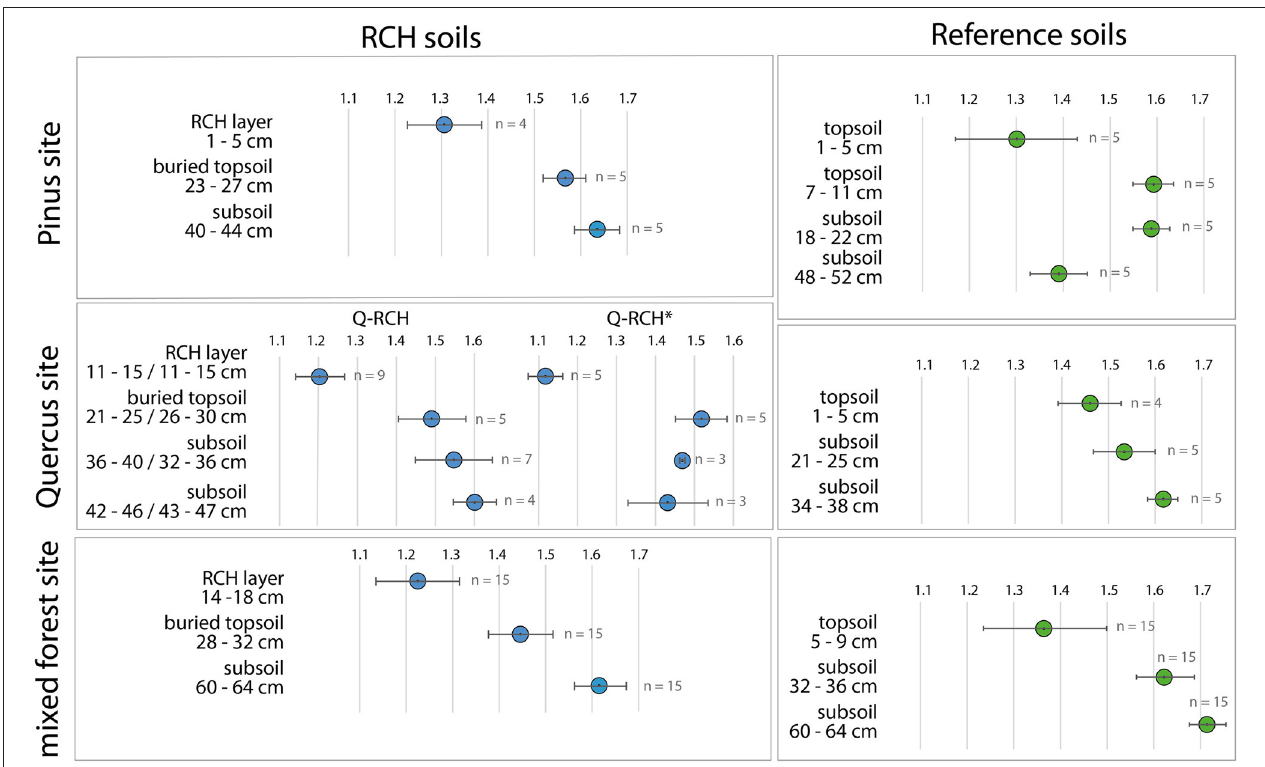
FIGURE 2 | Bulk density (mean and standard deviation) for horizons of the charcoal hearth and reference soils for both sites, determined from undisturbed soil samples.